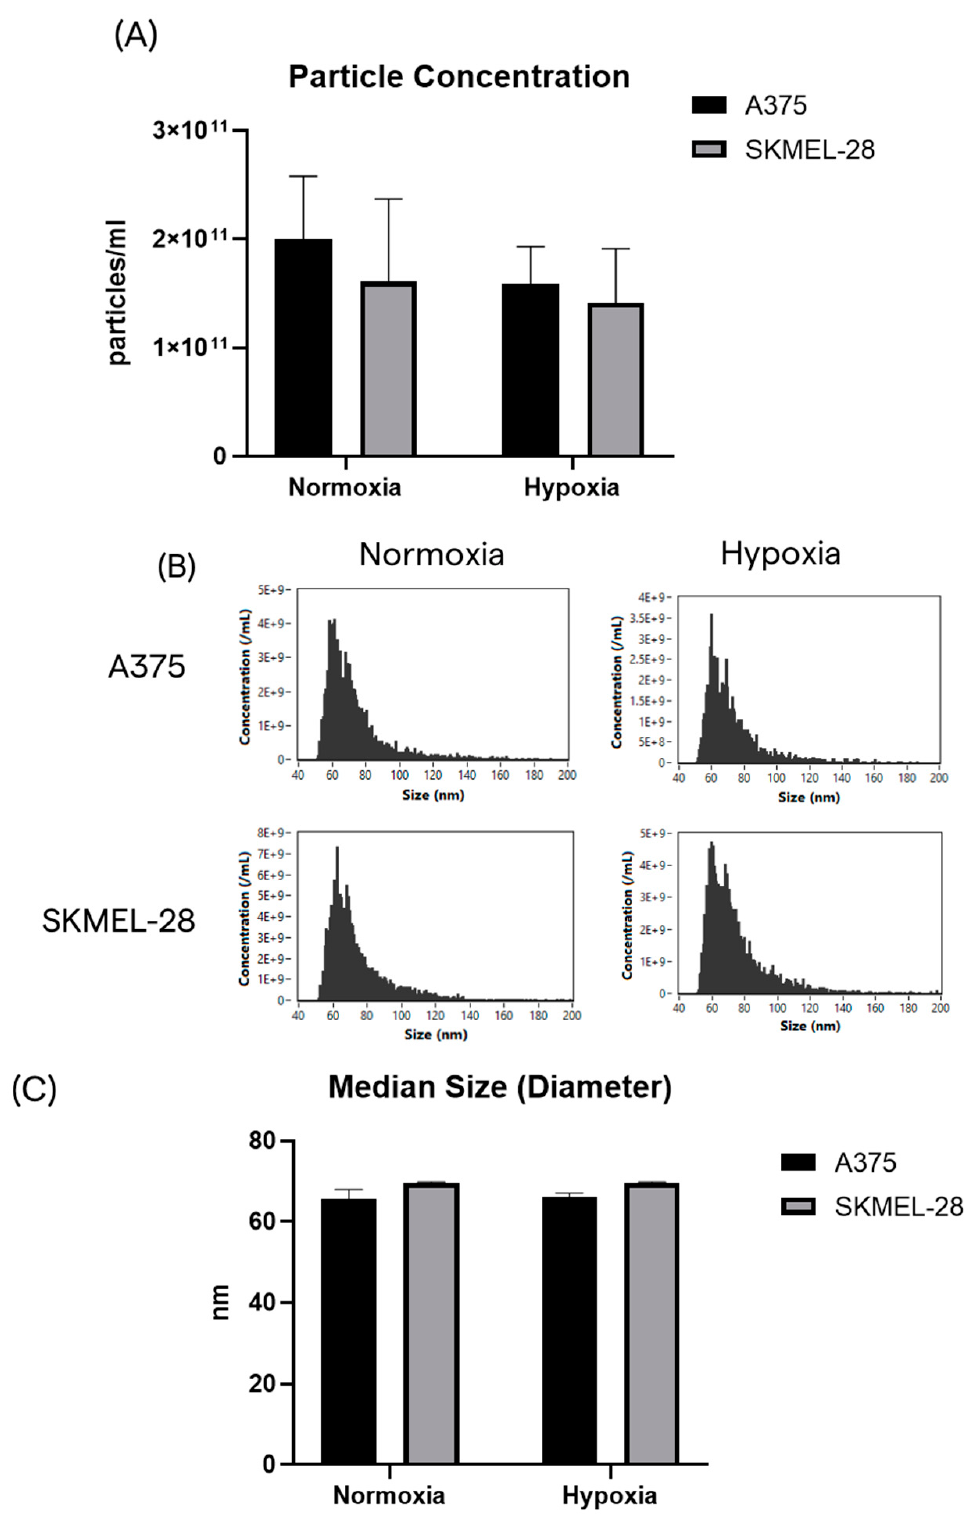
Figure 2. The A375 and SK-MEL-28 cells release similar populations of sEVs in terms of number and size. ( A ) The particle yield after SEC chromatography, starting from the same volume of CCM for each condition. ( B ) Size distribution profiles by nFCM. ( C ) Median size of purified sEVs from the A375 and SK-MEL-28 cell lines.